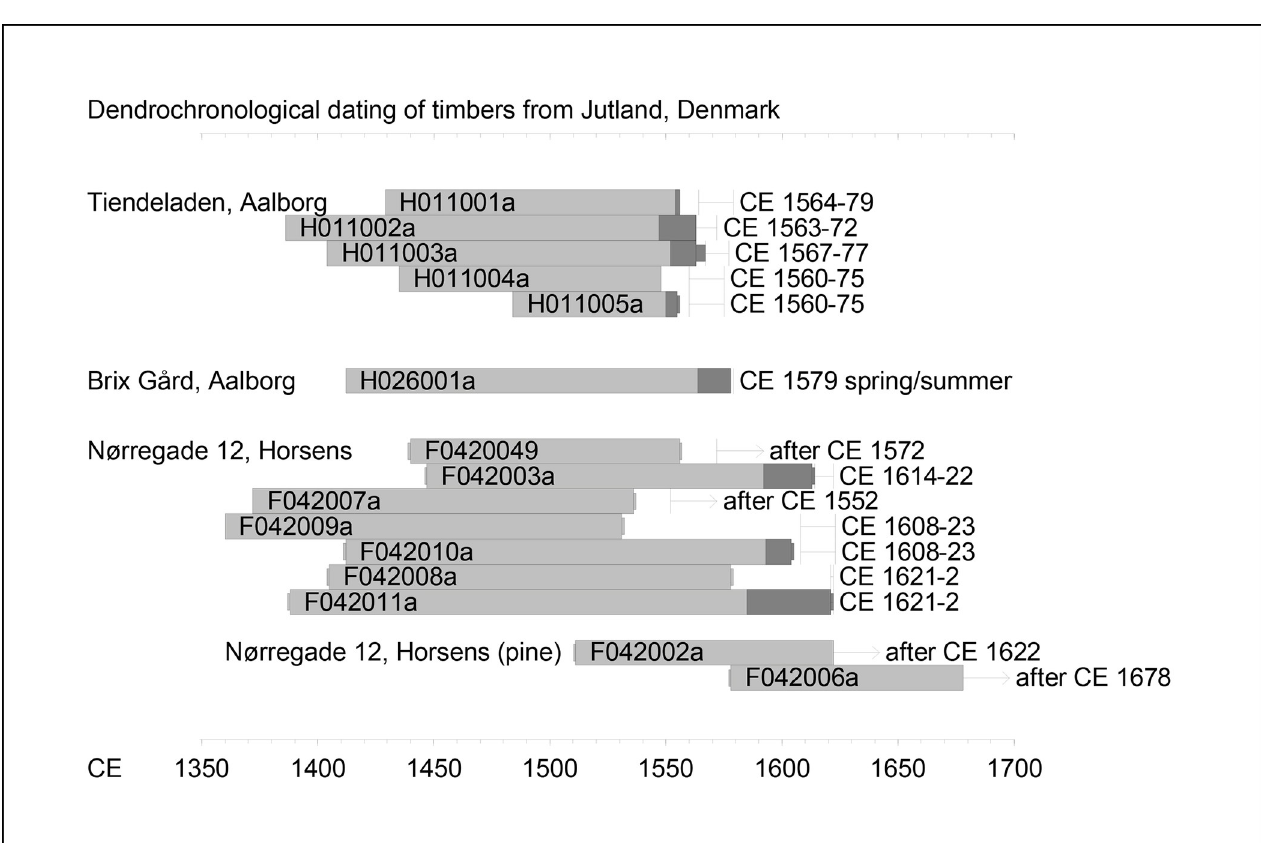
Fig 2. The dendrochronological dating of the timbers analysed. The grey bars represent the chronological position of each sample. The dark grey ends represent the sapwood. The line symbols represent the probable date for the felling of each tree, using the appropriate sapwood statistic (for Tiendeladen we used Norway [60] while for N ø rregade 12, Horsens we used Germany [18] (illustration: Aoife Daly).